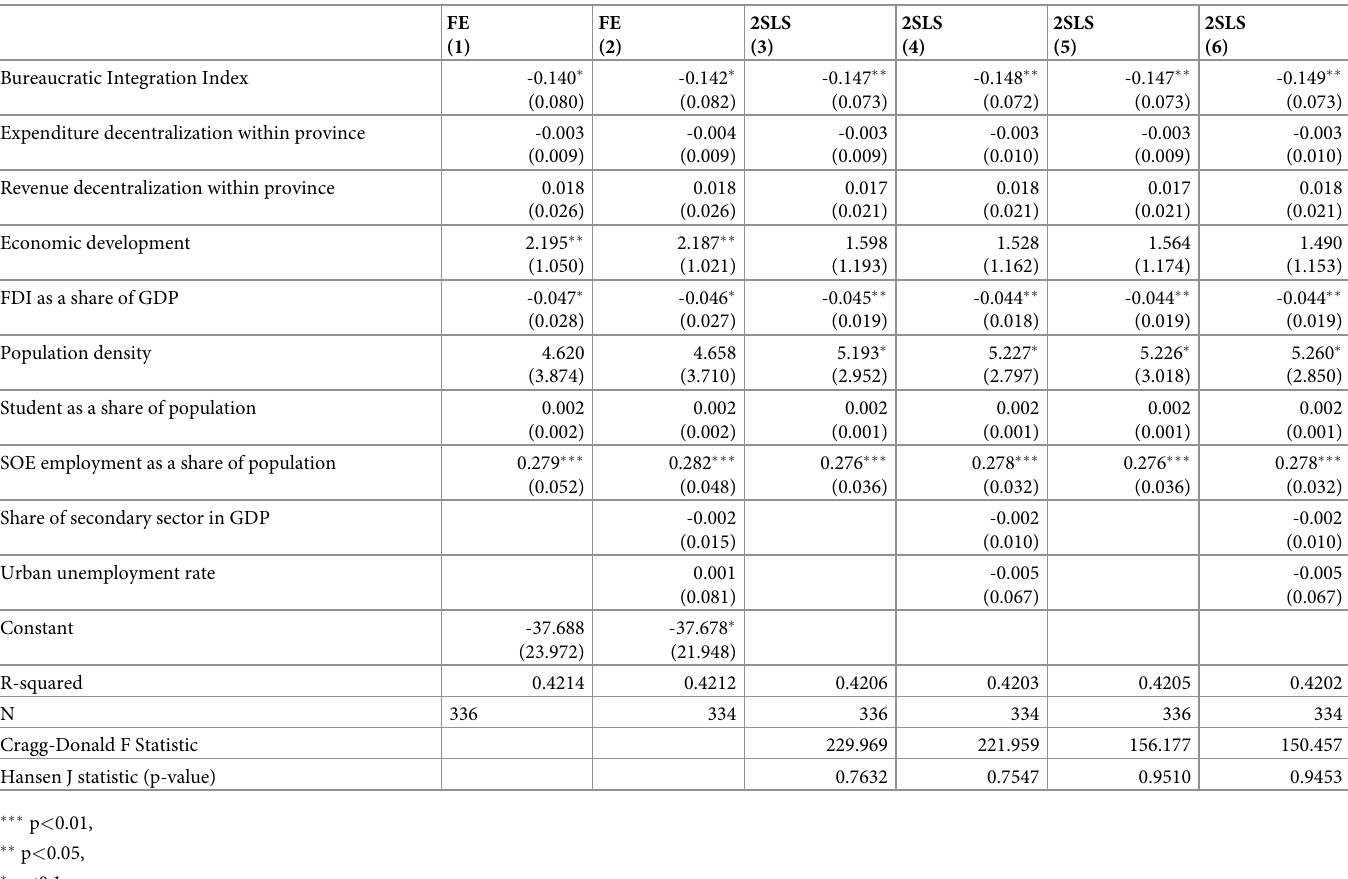
Table 2. Determinants of basic education provision in China,